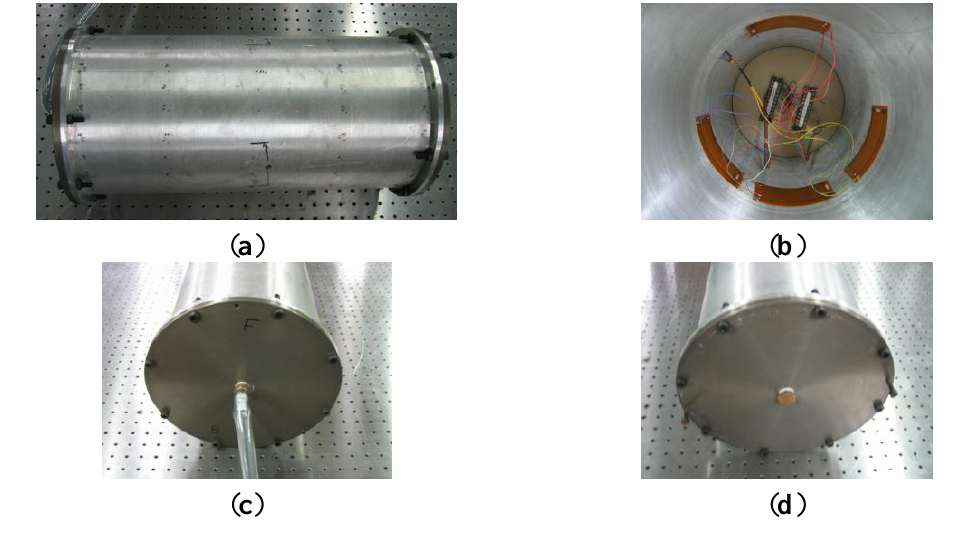
Figure 5. Photographs of the manufactured cylindrical shell structure. ( a ) Outside view, ( b ) Inside view, ( c ) Front view, and ( d ) Rear View.